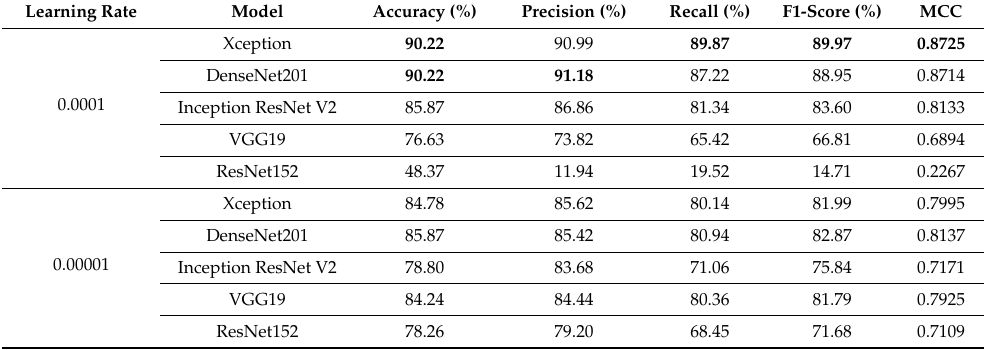
Table 13. Results of 400 × magnification factor in multi-classification mode; the highest results are shown in